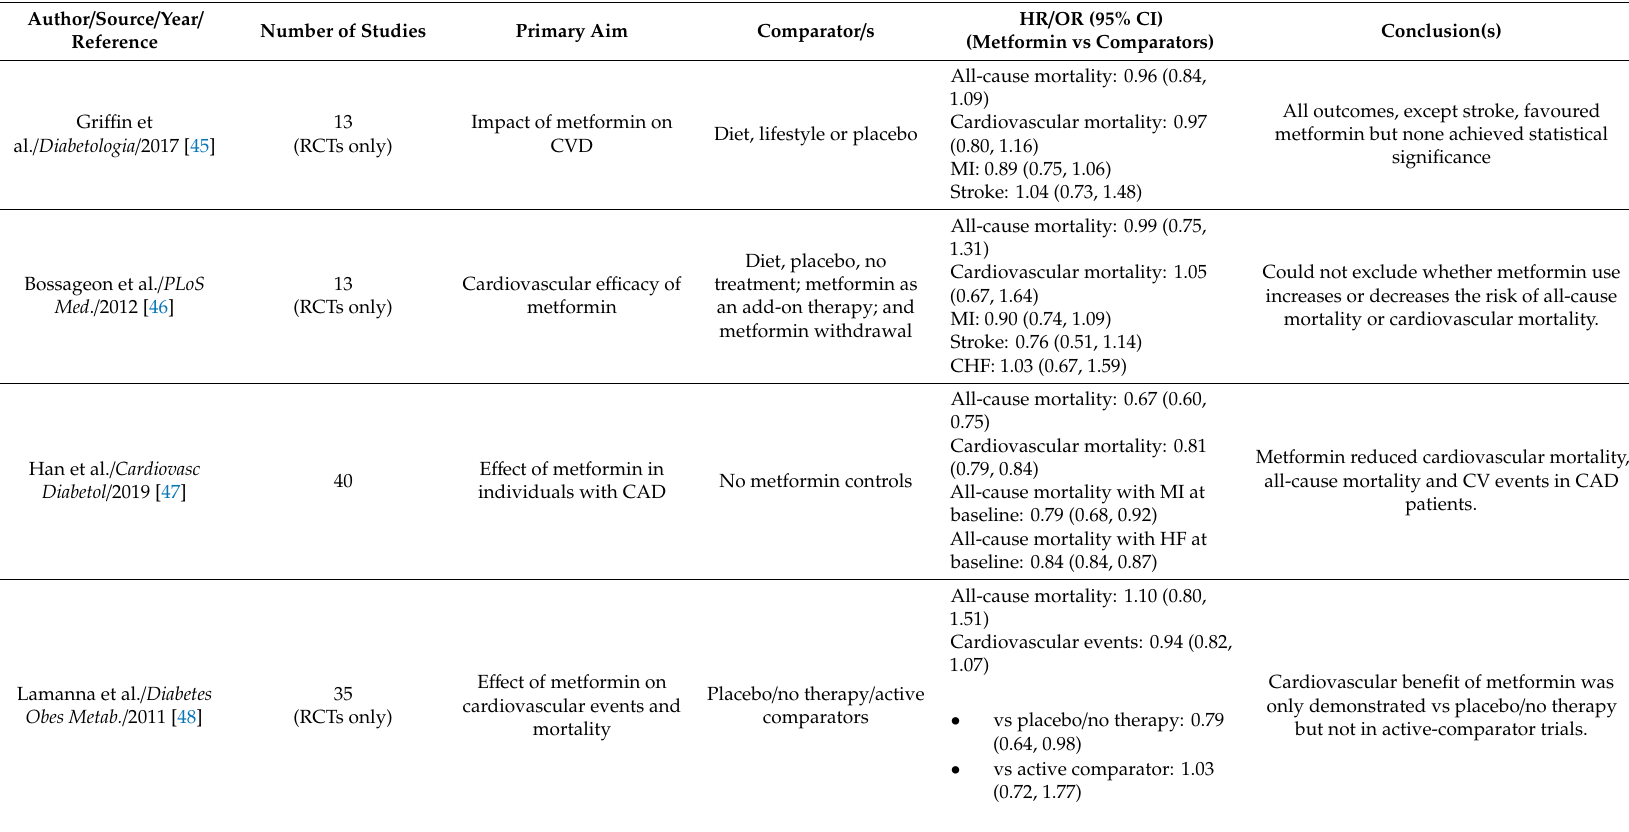
Table 1. Cardiovascular meta-analysis and systematic review data on